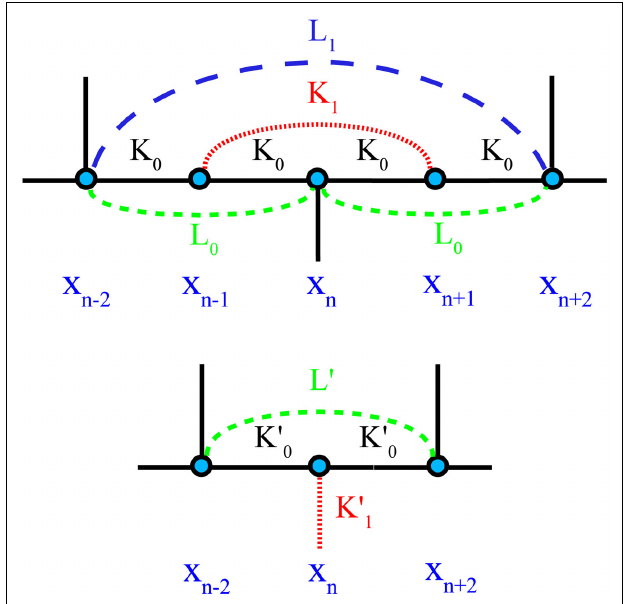
FIGURE 4 | Depiction of the (exact) RG step for the Ising model on HN5. This step is identical to that for HN3 in Figure 3 aside from the extra link L 1 spanning between x n − 2 and x n + 2 (top), which contributes to the renormalization of L (cid:9) 0